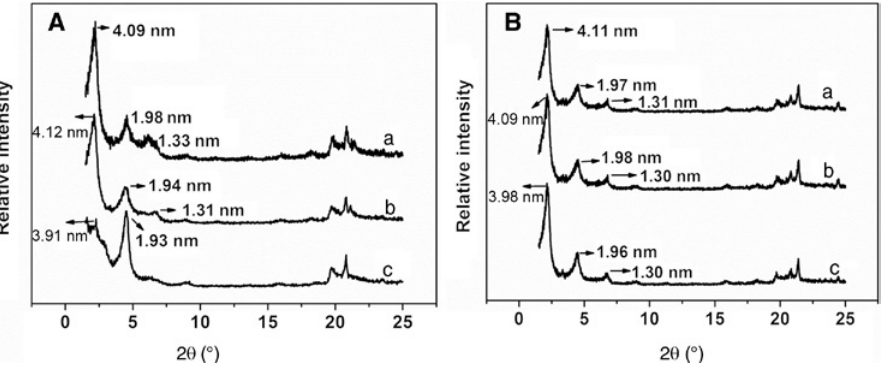
Figure 2: XRD patterns of cationic OMts. (A) XRD patterns of low surfactants ratio organically modified montmorillonite [a: OMt (1.0)-D, b: OMt (1.0)-S, c: OMt (1.0)-W]. (B) XRD pat- terns of high surfactants ratio organically modified montmorillonite [a: OMt (1.5)-D, b: OMt (1.5)-S, c: OMt